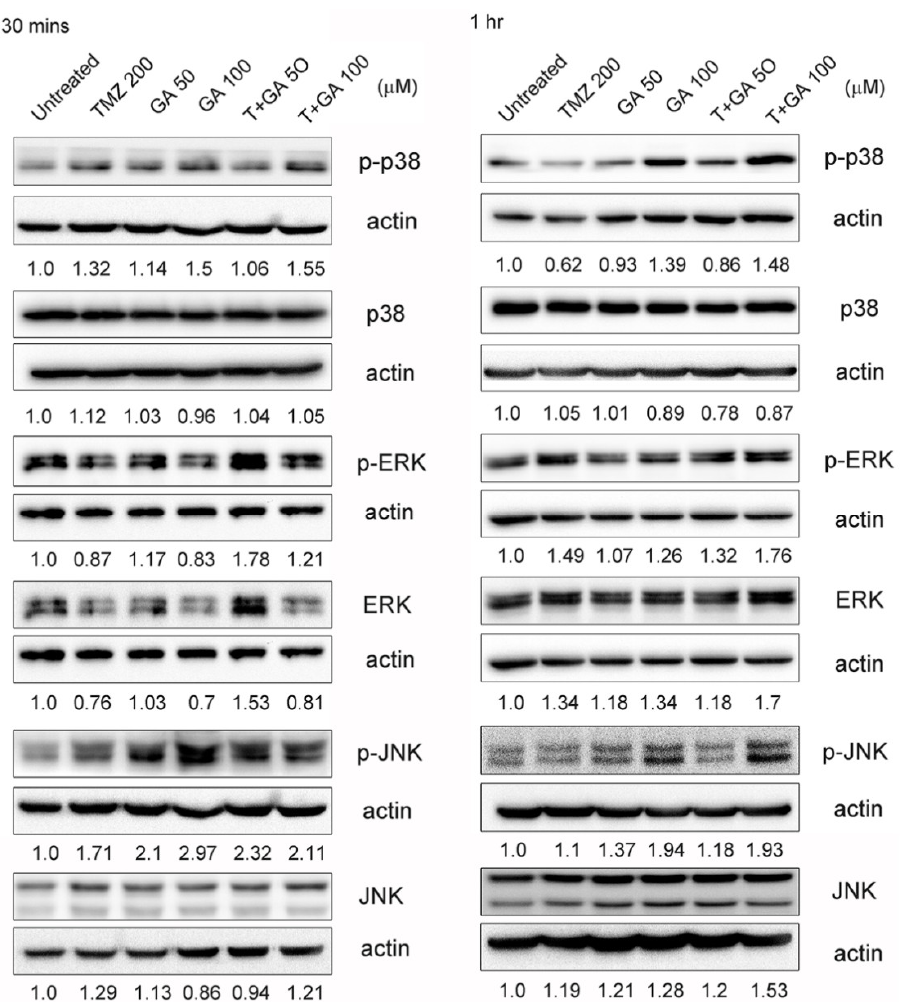
Figure 7. Expressions of MAPKs with TMZ, Ga or Ga/TMZ incubation. U87MG cells were cultured in 6 cm cultured dishes for 24 h, incubated with 200 µ M TMZ, 50 or 100 µ M Ga, or co-incubated with both for 30 min and 1 h. After incubation, total proteins were extracted to assess various protein expressions. After incubation, total proteins were extracted. The expression of MAPKs was detected by Western blotting. These experiments were conducted at least 3 times; an illustrative experiment is shown. The numbers show the densitometric data of various incubated cellular groups normalized to their related untreated group.